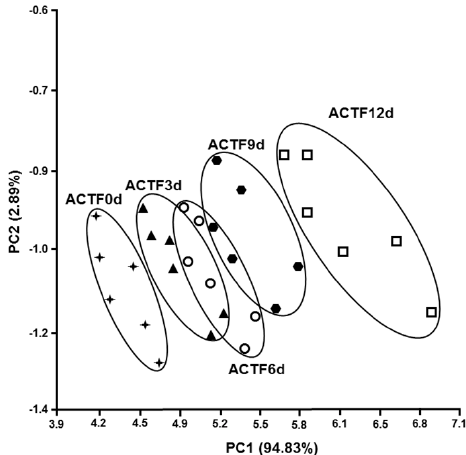
Figure 6. The PCA plot of the scores produced by the 10 sensor responses to the headspace of carrageenan coated trout fillets plus essential lemon oil (ACTF) along the first two principal components. The number in parentheses indicates the proportion of the total variance explained by each principal component. The abbreviations near the clusters are ACTF0d = carrageenan coated trout fillet day 0 of storage; ACTF3d = carrageenan coated trout fillet day 3 of storage; ACTF6d = carrageenan coated trout fillet 6 days of storage; ACTF9d = carrageenan coated trout fillet 9 days of storage; ACTF12d = carrageenan coated trout fillet 12 days of storage. Results are representative of three trout analyzed for each experimental group.